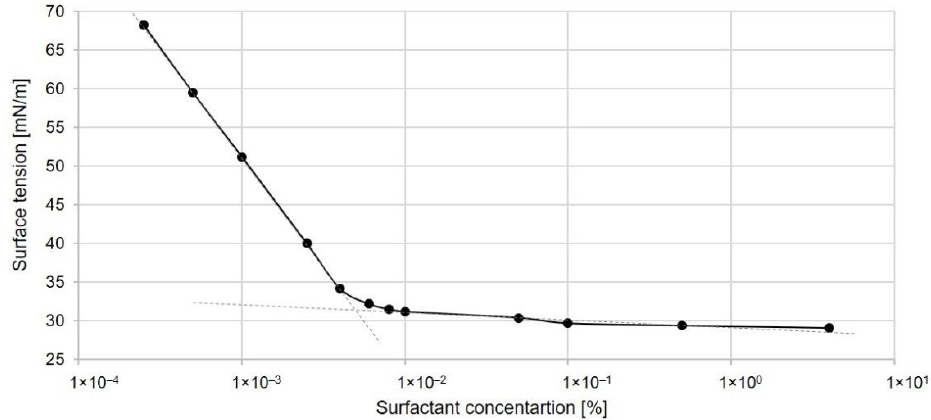
Figure 1. Variation in surface tension as a function of surfactant concentration.